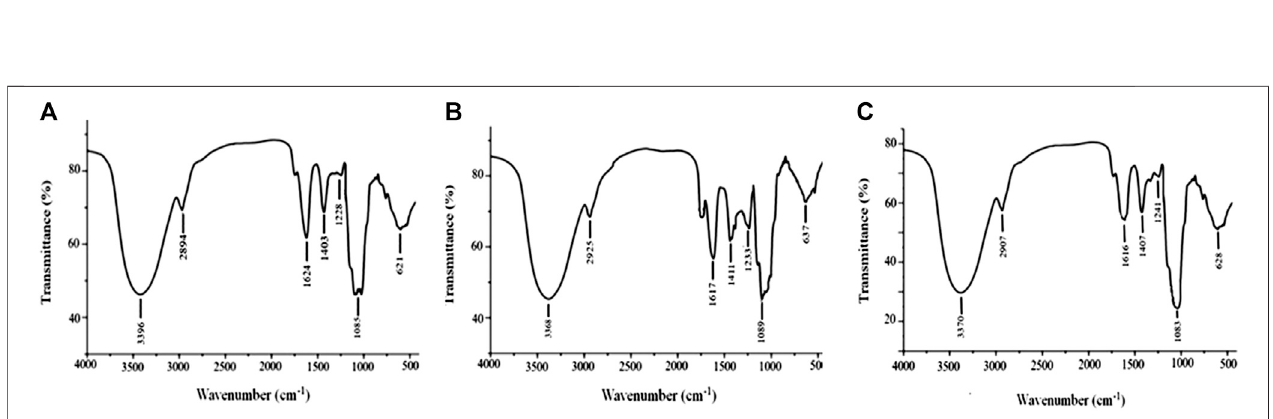
FIGURE 3 | Infrared spectra of APS-I (A) , APS-II (B) , and APS-III (C) .